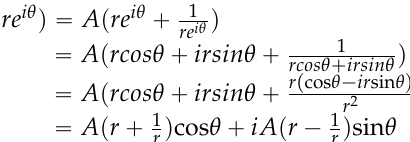
Figure 11. Fluid flow around a circular obstacle.